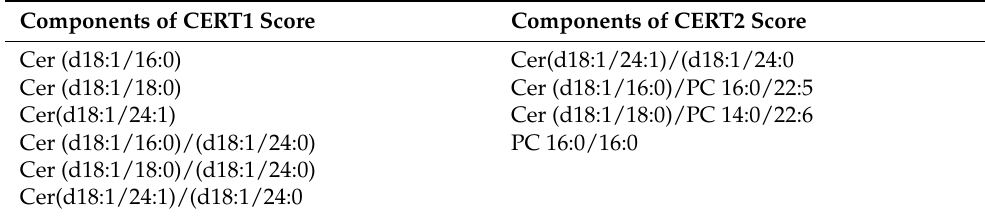
Table 2. Components of the CERT1 and CERT2 scores. Components of CERT1 Score Components of CERT2